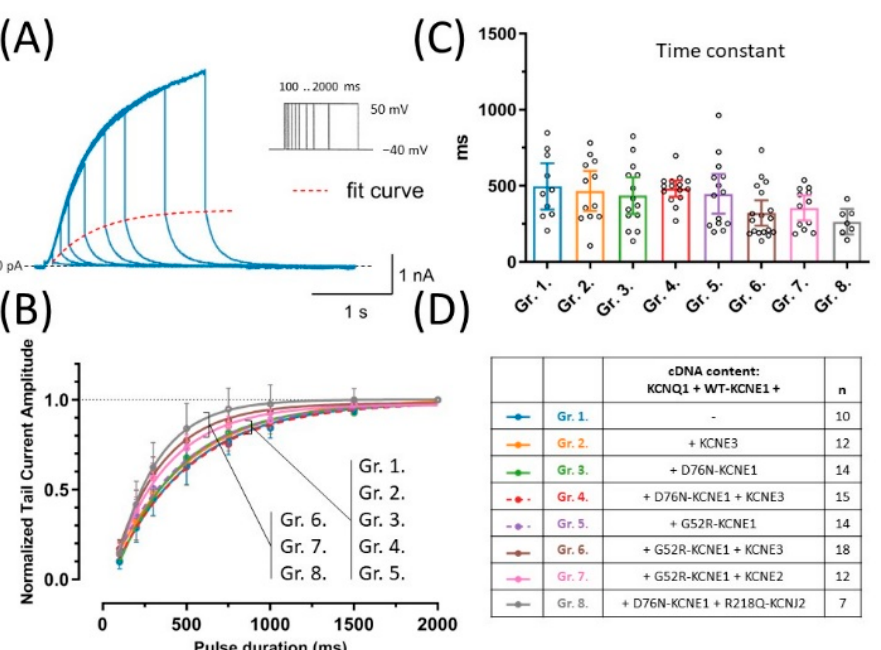
Figure 3. Activation kinetics were assessed by the envelope of tail currents protocol, which consisted of a series of 50 mV test pulses of increasing duration. A representative recording of an experiment in group 1 (blue), the fitted curve (dashed red) and the voltage clamp protocol are shown ( A ). Normalized peak tail currents were plotted against test pulse duration ( B ), time constants were extracted from non-linear curve fits ( C ). Symbols and error bars represent mean values ±95% CI, continuous lines represent curve fits to average values. One-way ANOVA showed no statistically significant difference between group means. cDNA content of transfection mixtures are indicated in ( D ), where ‘n’ means number of experiments .